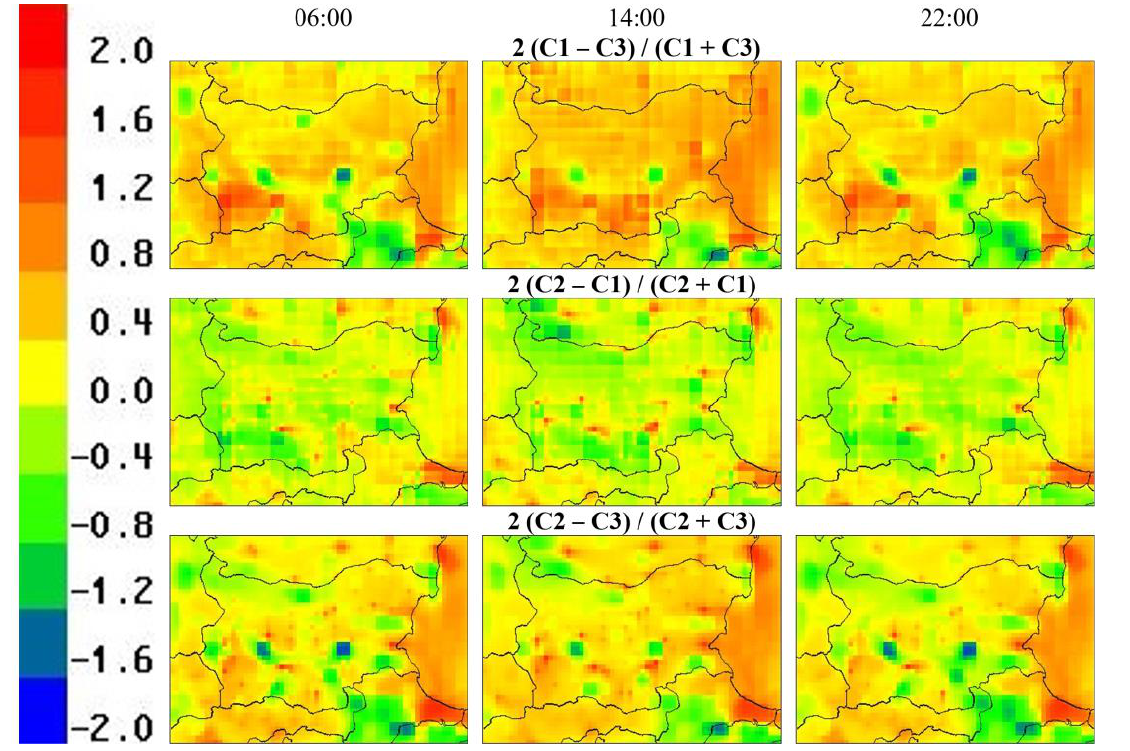
Figure 4. Annually averaged relative differences of the surface concentrations of SO 2 between cases C1 and C3, C2 and C1, C2 and C3 respectively.